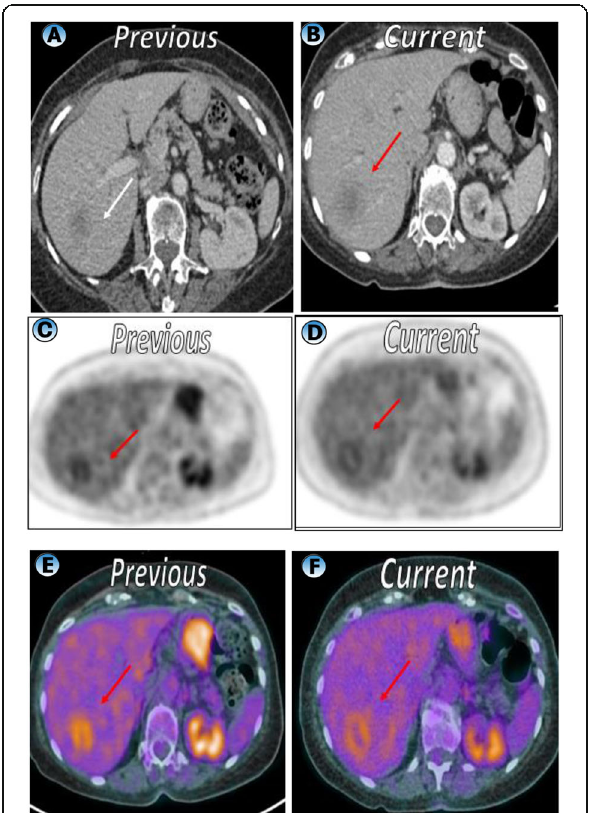
Fig. 3 A 77-year-old male patient with given history of cancer colon with hepatic metastatic focal lesion under treatment. PET CT was done to evaluate therapeutic response. a Pre and b post treatment axial CT images of the liver revealed mild size progression of the deep parenchymal hypodense hepatic focal lesion seen at segment VI/VII in the current study measures 3 cm in diameter (red arrow) compared to 2.6 cm in the previous study (white arrow) this assume progressive course of the disease. c Pre and d post treatment axial PET images of the liver and e pre and f post treatment axial fused PET/CT images of the liver revealed mild size progression of the deep parenchymal hypodense hepatic focal lesion seen at segment VI/VII yet showed partial metabolic response with SUVmax 3.5 in the current study compared to SUVmax 4.5 in the previous study; so the patient actually running regressive course and this size progression attributed to breaking